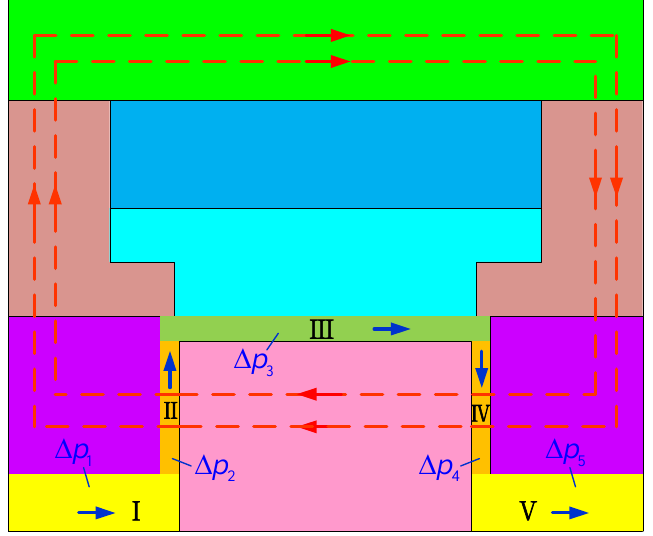
Figure 4. Schematic configuration of the distribution of pressure